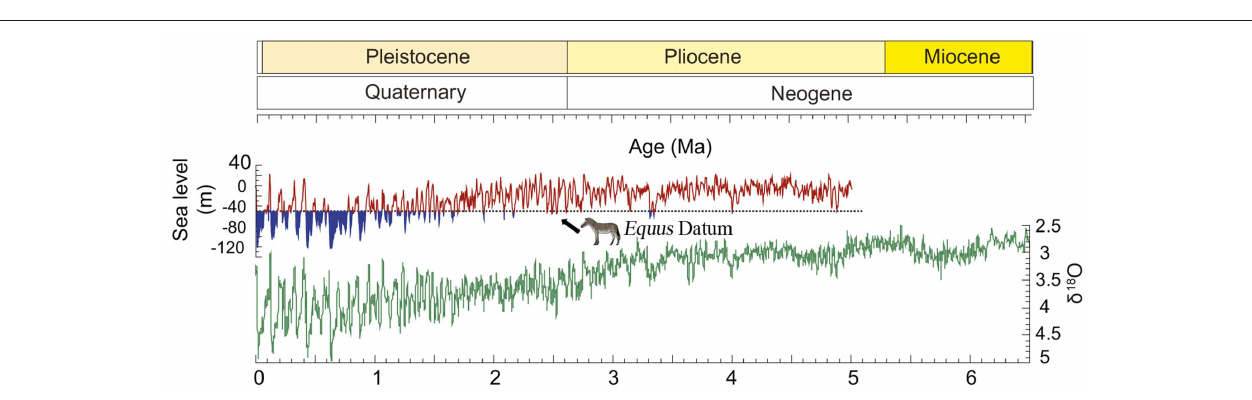
FIGURE 15 | Equus Datum, global sea-level and global benthic δ 18 O compilation. Blue shading of the sea-level curve indicates times when global sea-level dropped below 50m and the Bering Strait was likely exposed (modified after O’Regan et al.,